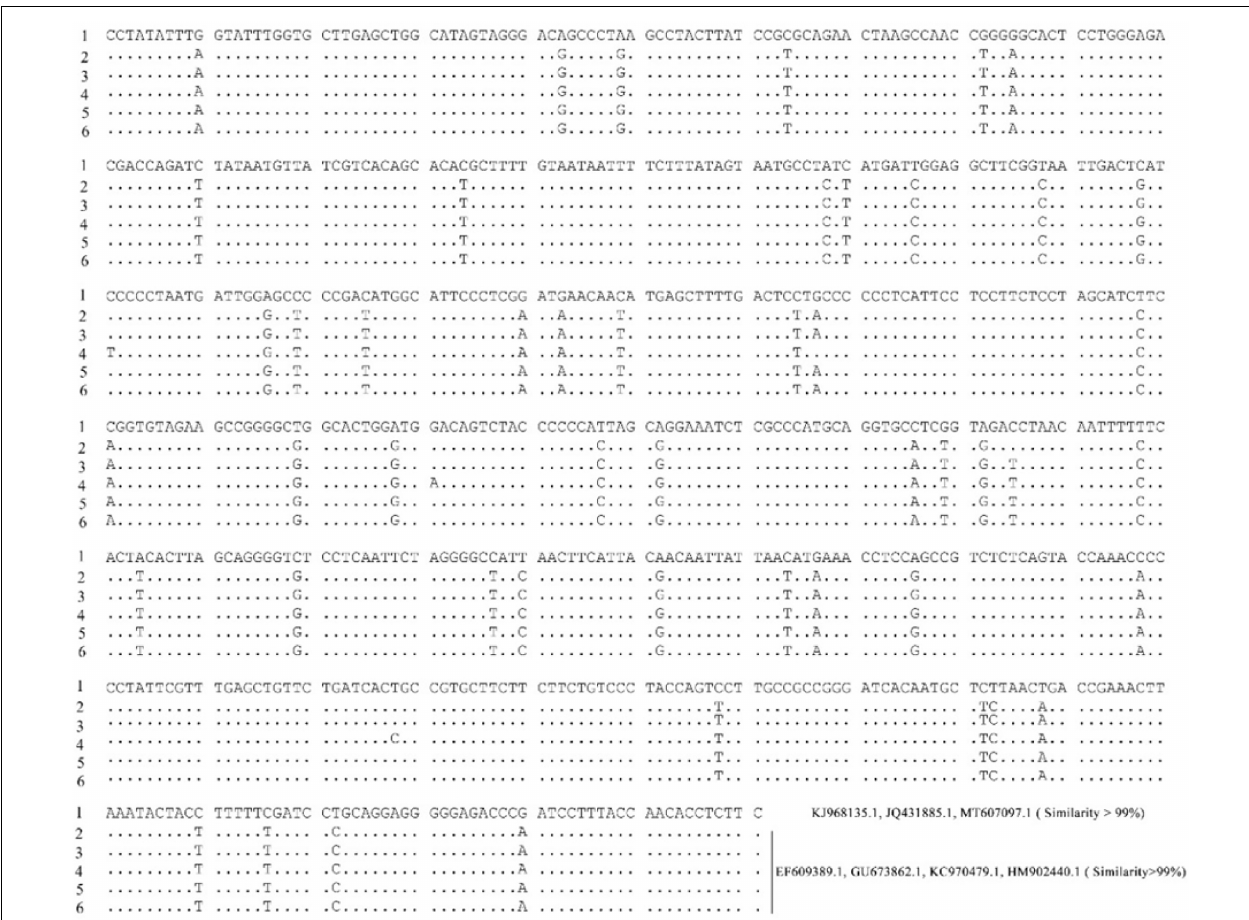
FIGURE 2 | Sequences of six L. olivaceus specimens and accession numbers of sequences matched in Nt database.